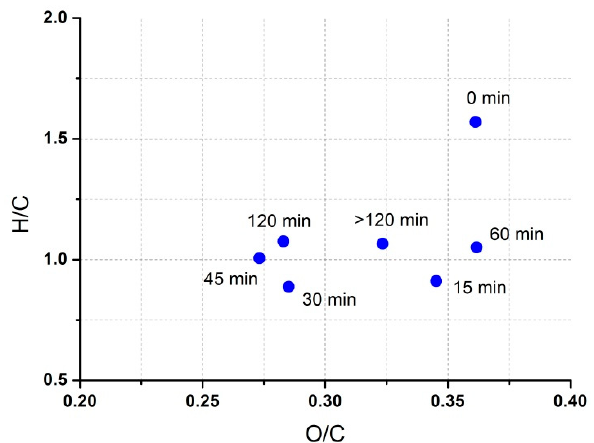
Figure 1. Atomic ratio diagram for LH sampled at different treatment times.